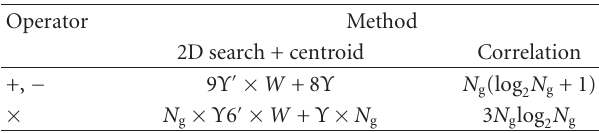
Table 5: Complexity estimate.